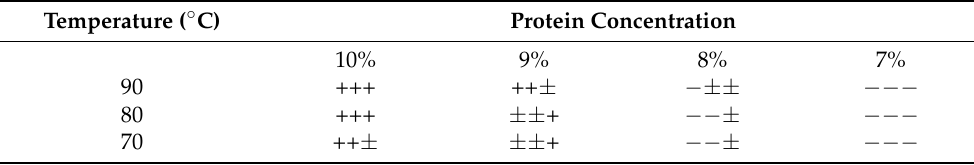
+ firm gel forming. ± gel forming tendency. − lack of gel.